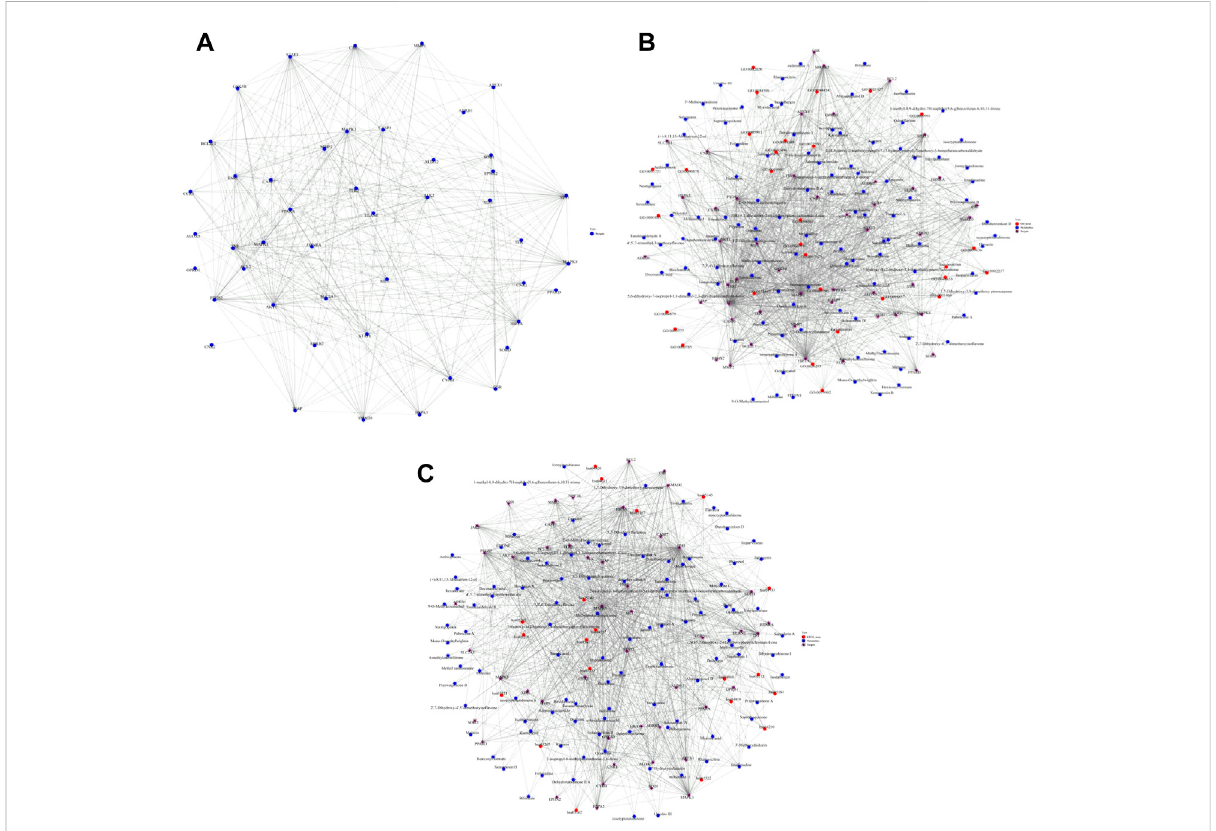
FIGURE 3 PPI network construction, metabolite-target-GO and metabolite-target-KEGG pathway interaction networks. (A) : PPI network comprised 46 nodes and 369 edges. The nodes suggested targets, the edges indicated the interactions between the nodes, and the size of the nodes representedthevalueofthedegree.ThekeytargetsofQSYQinthetreatmentofmyocardialI/RinjuryincludedAKT1,Bcl-2,Caspase-1,GSK-3 β ,p53, etc., (B) : Metabolite-target-GO interaction network; (C) : Metabolite-target-KEGG pathway interaction